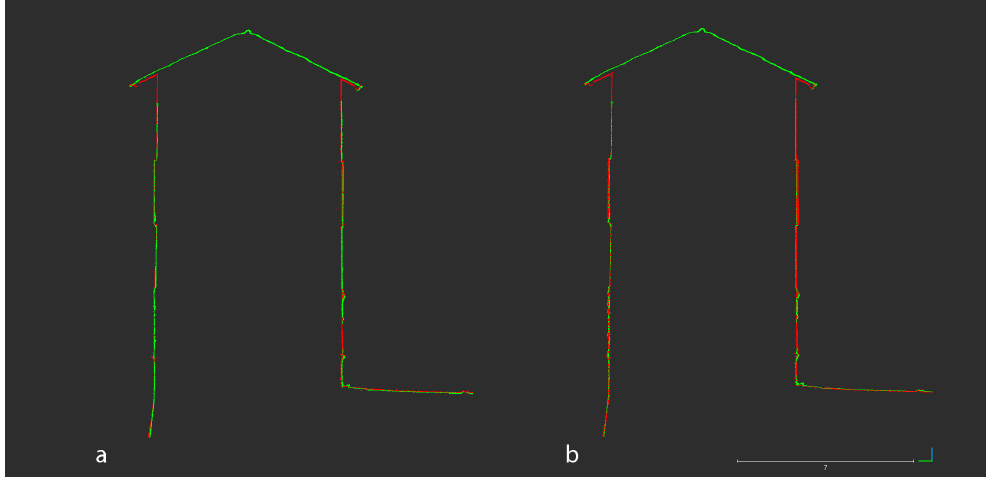
Figure 22. Detail on Profile 2 ICP alignment. P1 (green) aligned with SX10 data (red): ( a ) before the alignment; ( b ) after the alignment.